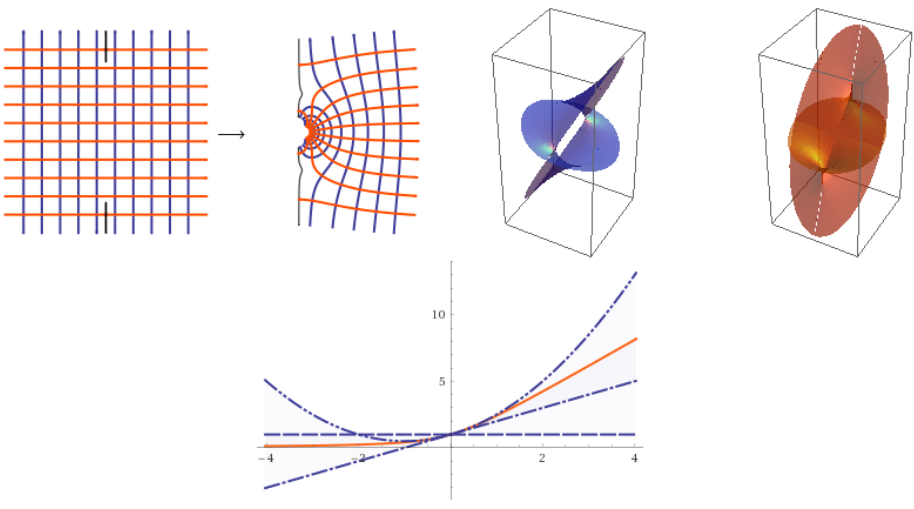
Figure 2. The complex plane, Riemann surface and the asymptotic expansions of (cid:112) ( ζ + ζ 2 + 1 ) ,